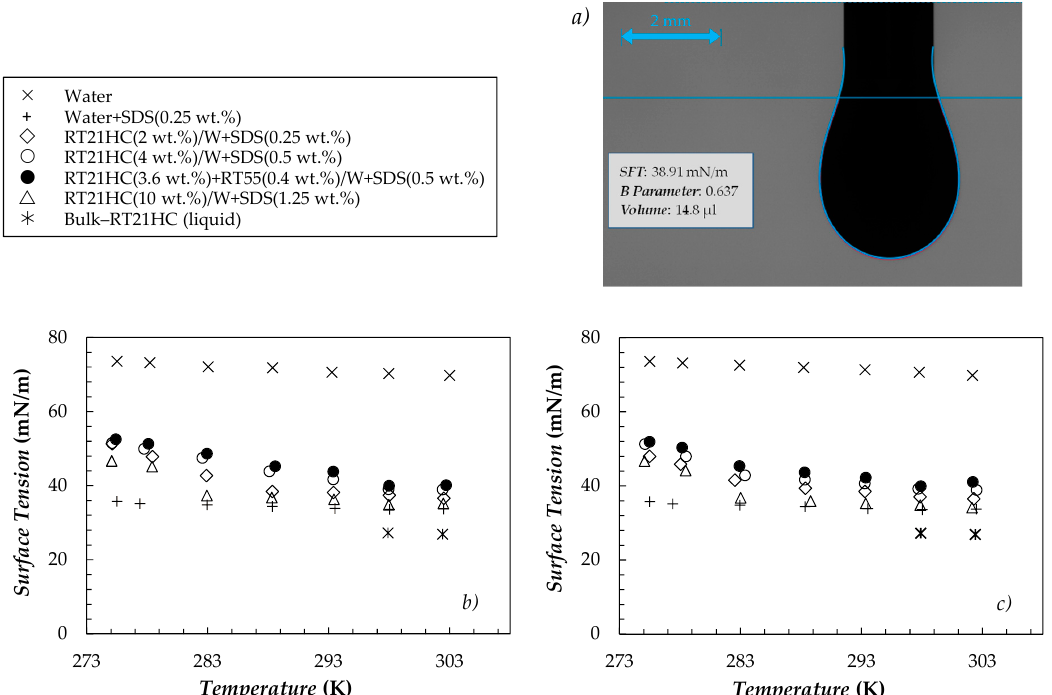
Figure 6. ( a ) Droplet capture obtained at 303 K for the RT21HC(4 wt.%) / Water nano–emulsion. ( b , c ) Surface tension results of the different samples obtained from ( b ) increasing and ( c ) decreasing temperature experiments.